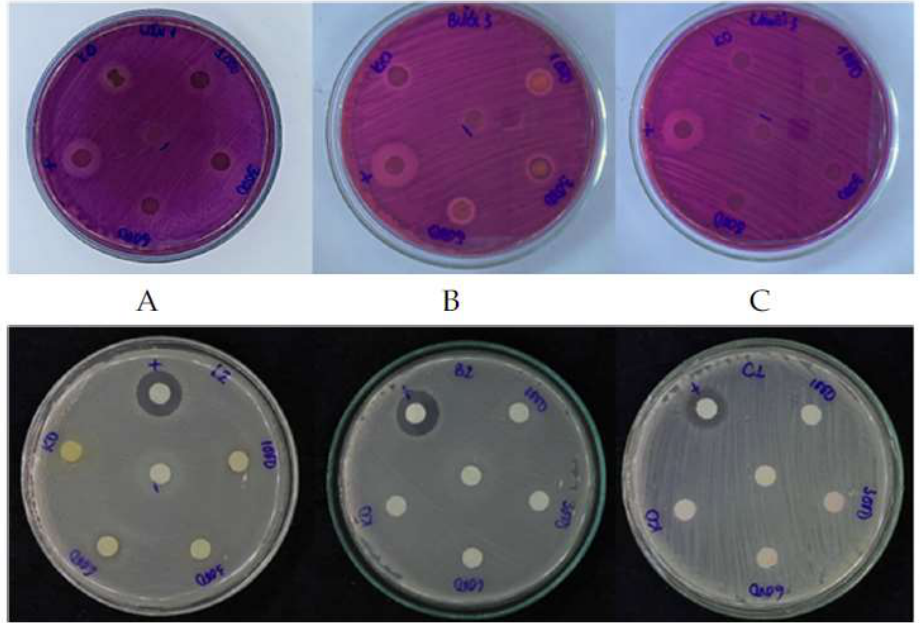
Figure 1. Inhibition zone of three fermented fruit peel extracts against E. coli (purple medium) and